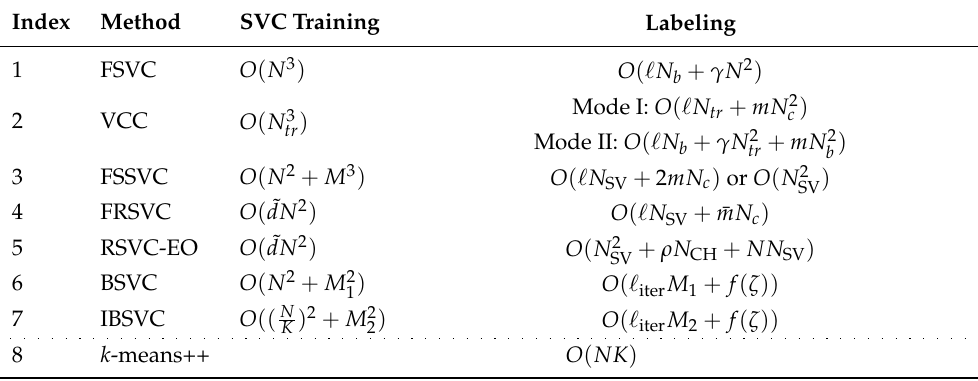
Table 1. Time complexity analysis of the state-of-the art